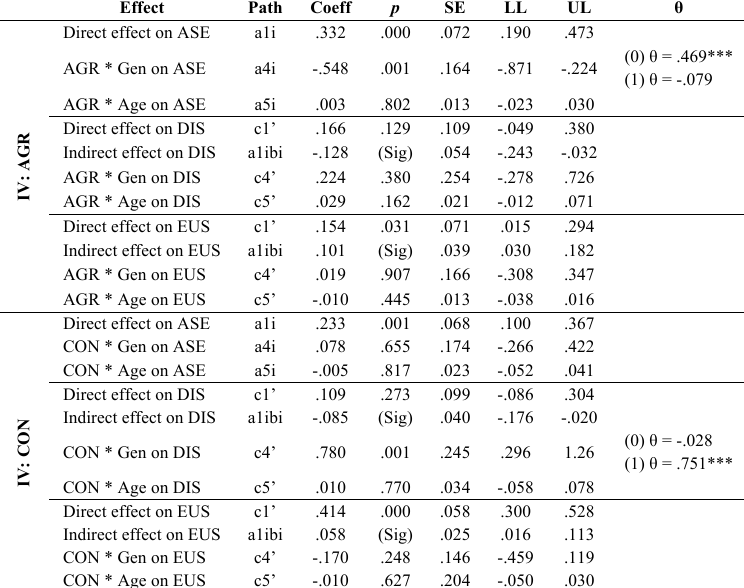
Results of the moderated